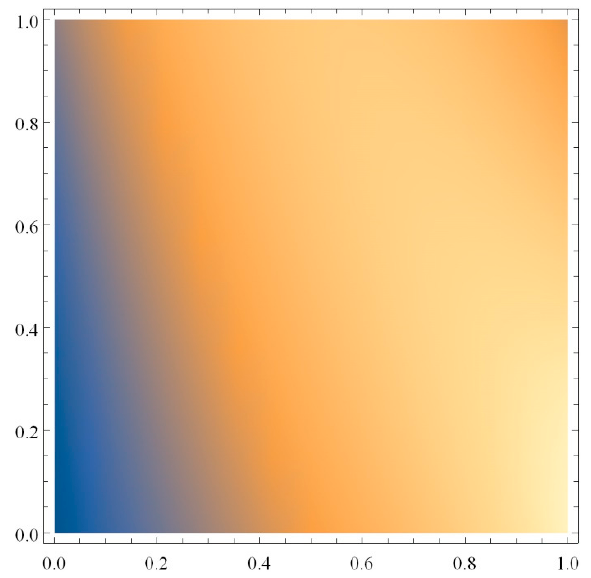
Figure 13. Density graph of 𝑈(𝑥, 𝑡) versus depth 𝑥 for Equation (37).